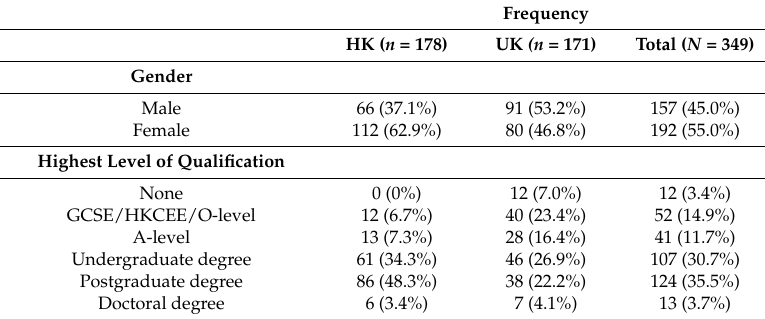
Table 1. Demographic